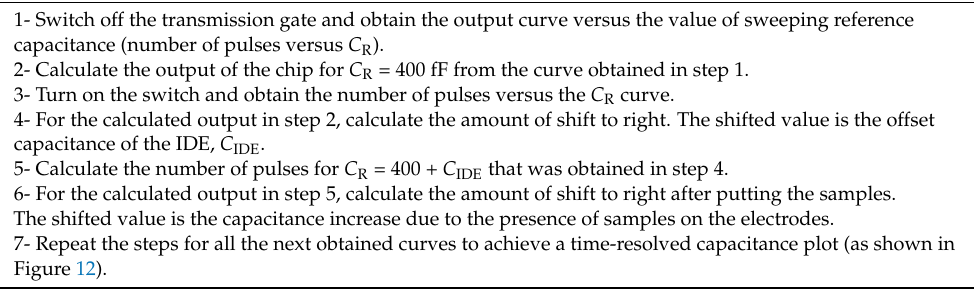
Algorithm 1. Capacitance extraction algorithm from the 3D footprint.